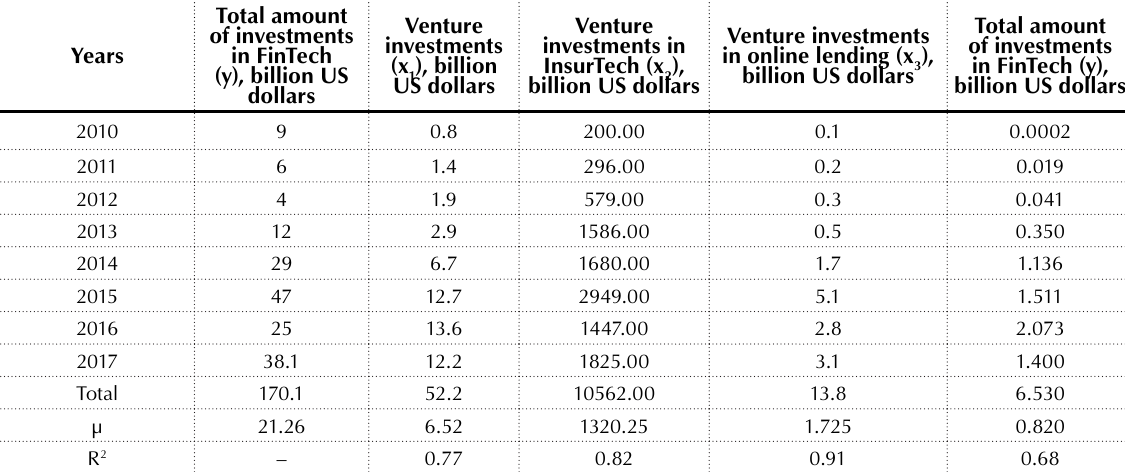
Table 2. Output data for constructing a regression model of FinTech market